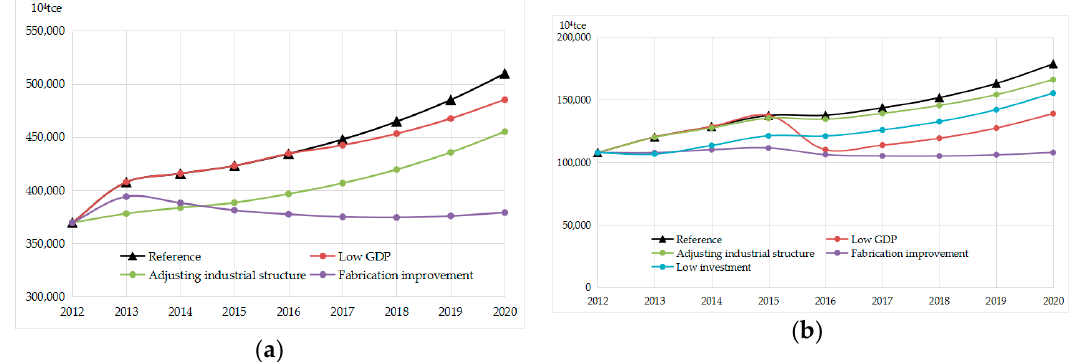
Figure 7. Energy consumption in various scenarios: ( a ) TPEC and ( b ) EECS.